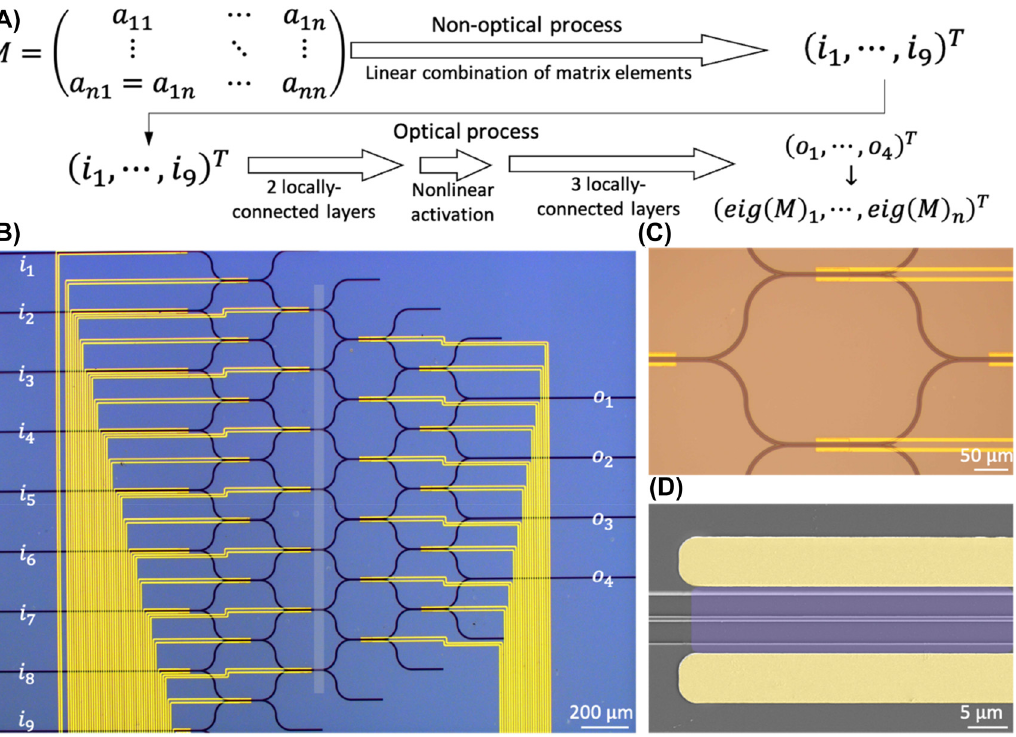
Figure 1: The framework of the proposed photonic neural network. (A) Schematic diagram of the process for realizing the target task. Elements of the symmetric matrix are first linearly combined into input information for the optical part of the network. Signals goes through locally-connected layers and nonlinear layers and are coupled out to represent eigenvalues of the original matrix. (B) Optical micrograph of the characteristic structure of the proposed network with 9 input ports ( i 1 – i 9 ) and 4 output ports ( o 1 – o 4 ). (C) Optical micrograph of one single cell which contains two phase shifters and a merging structure. (D) Electron micrograph of a phase shifter for thermo-optical modulation, purple: single-layer graphene; yellow: Au/Cr